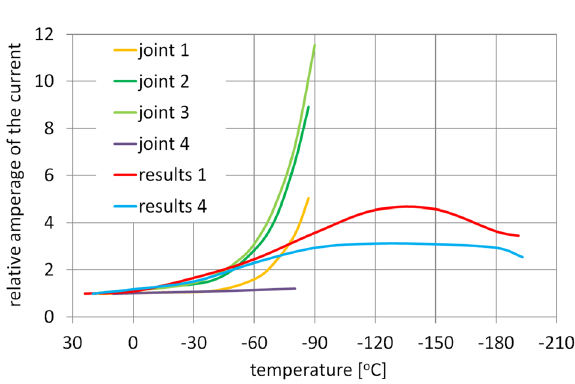
Figure 15. Comparison of the relative amperage of the current supplied to the RA joints of the MVACS lander 8 and the designed